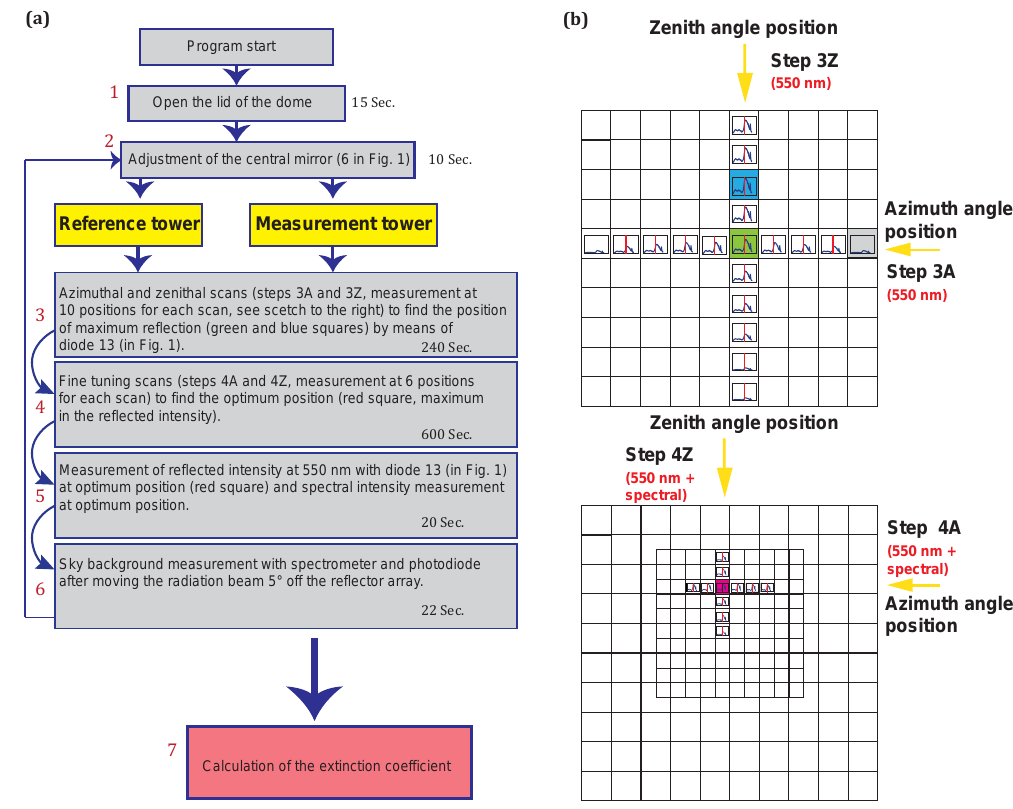
Fig. 3. (a) Flowchart of the measurement procedure. After opening the dome (step 1), the radiation beam is directed towards the retroreflector of the reference tower (step 2). Steps 3–6 are executed for both towers successively. For each tower the procedure takes 15min. The intensity optimization procedure by moving the mirror positions (steps 3–4) is shown schematically in (b) , starting with the adjustment of the azimuth angle (upper panel, gray box). The maximum of the reflected intensity for this scan is highlighted in green. The maximum value during the zenith-angle adjustment is indicated by a blue box. Then the fine tuning with the photodiode is performed (lower panel, optimum position indicated by a red box), followed by the measurement of the spectral intensity with the spectrometer and the 550nm diode (step 5). Afterwards the radiation beam is moved horizontally by 5 ◦ (off the reflector, step 6) and an atmospheric background measurement is performed. Then the SÆMS radiation beam is directed to the next tower and the procedure (steps 3–6) are conducted again. Finally the spectral extinction coefficient is calculated (step